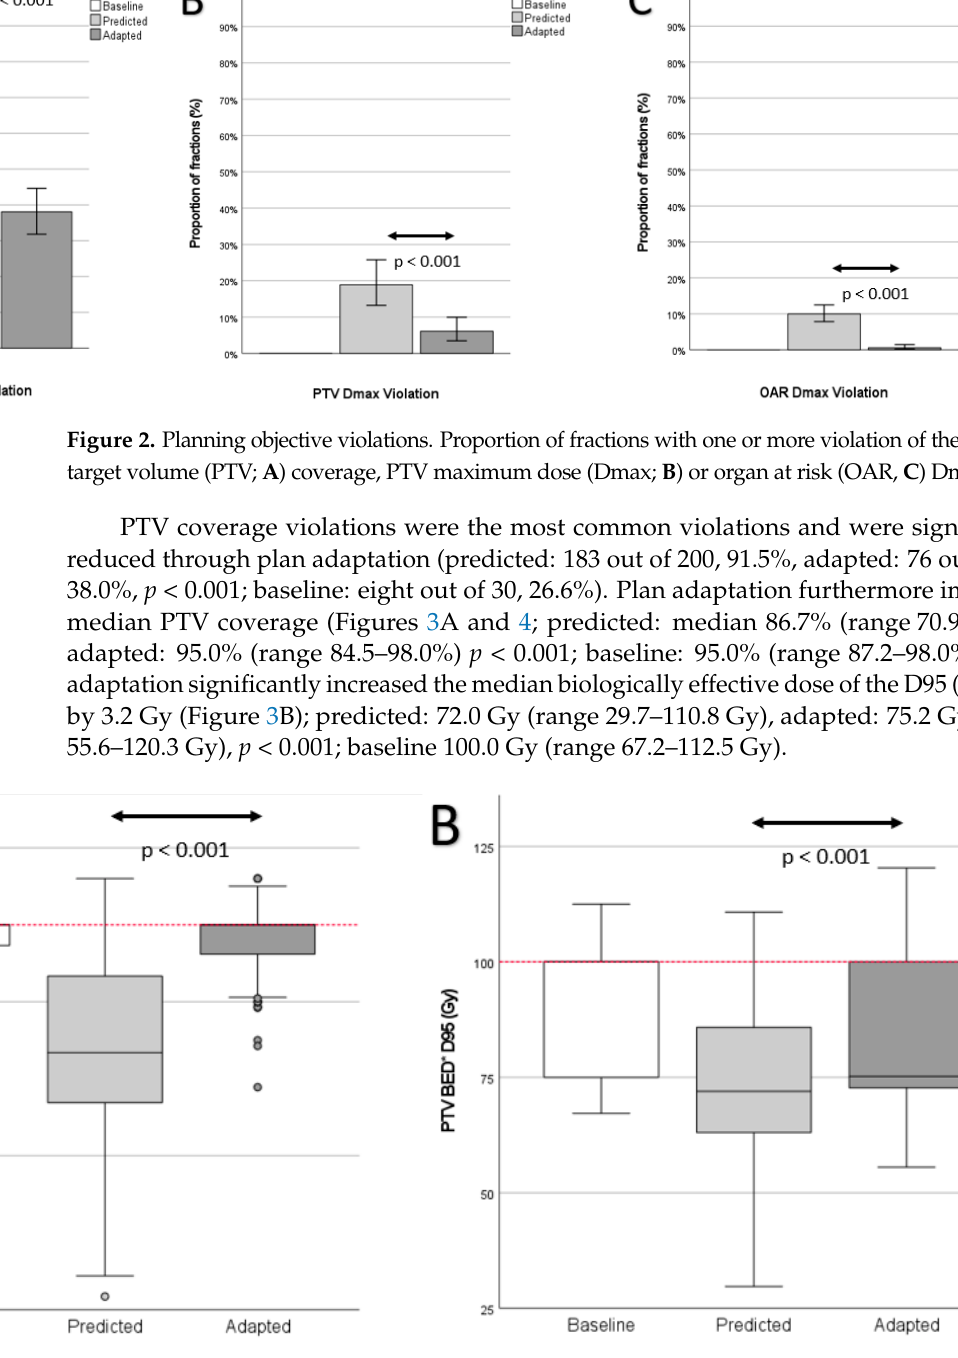
5 of 11 Figure 1. Case study. ( A ) Baseline plan (50 Gy in 10 fractions) with already slightly impaired PTV coverage (91%) due to proximity to the intestines (brown). ( B ) Daily online MRI-guidance revealed that the small bowel had moved slightly forward in ventral direction (dashed light-blue circle) lead-